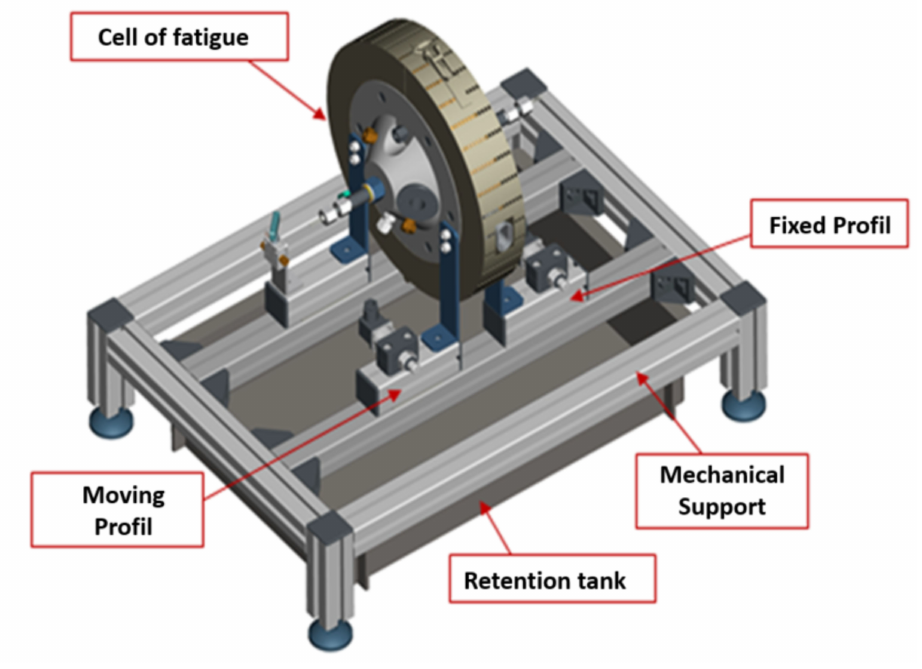
Figure 2. View of the spherical bending device fatigue